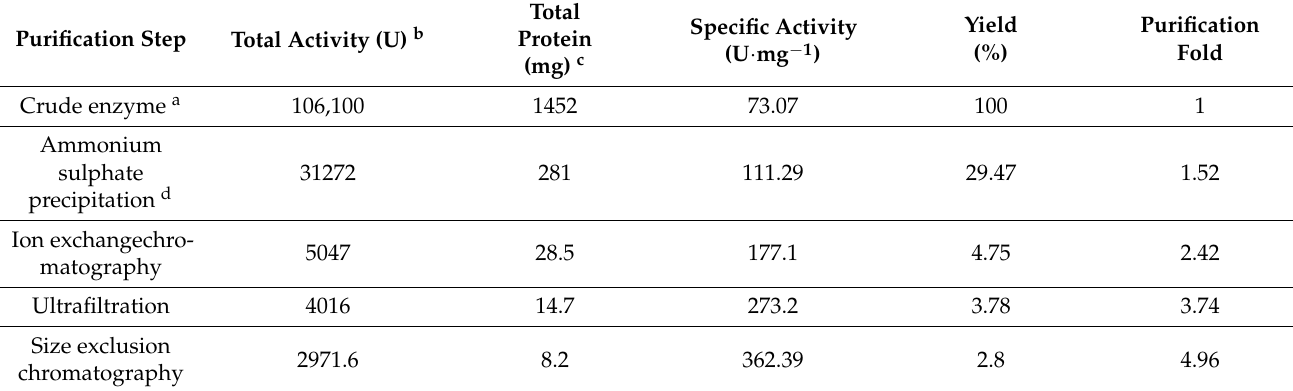
Table 2. Purification table of Beauveria bassiana SAN01